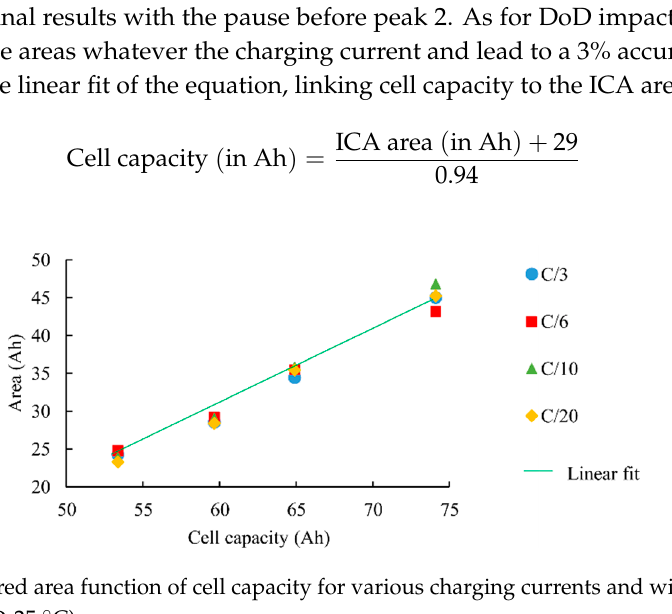
Figure 9. ICA deformation function of the charging current (100% DoD-25 °C-SoH 80%).